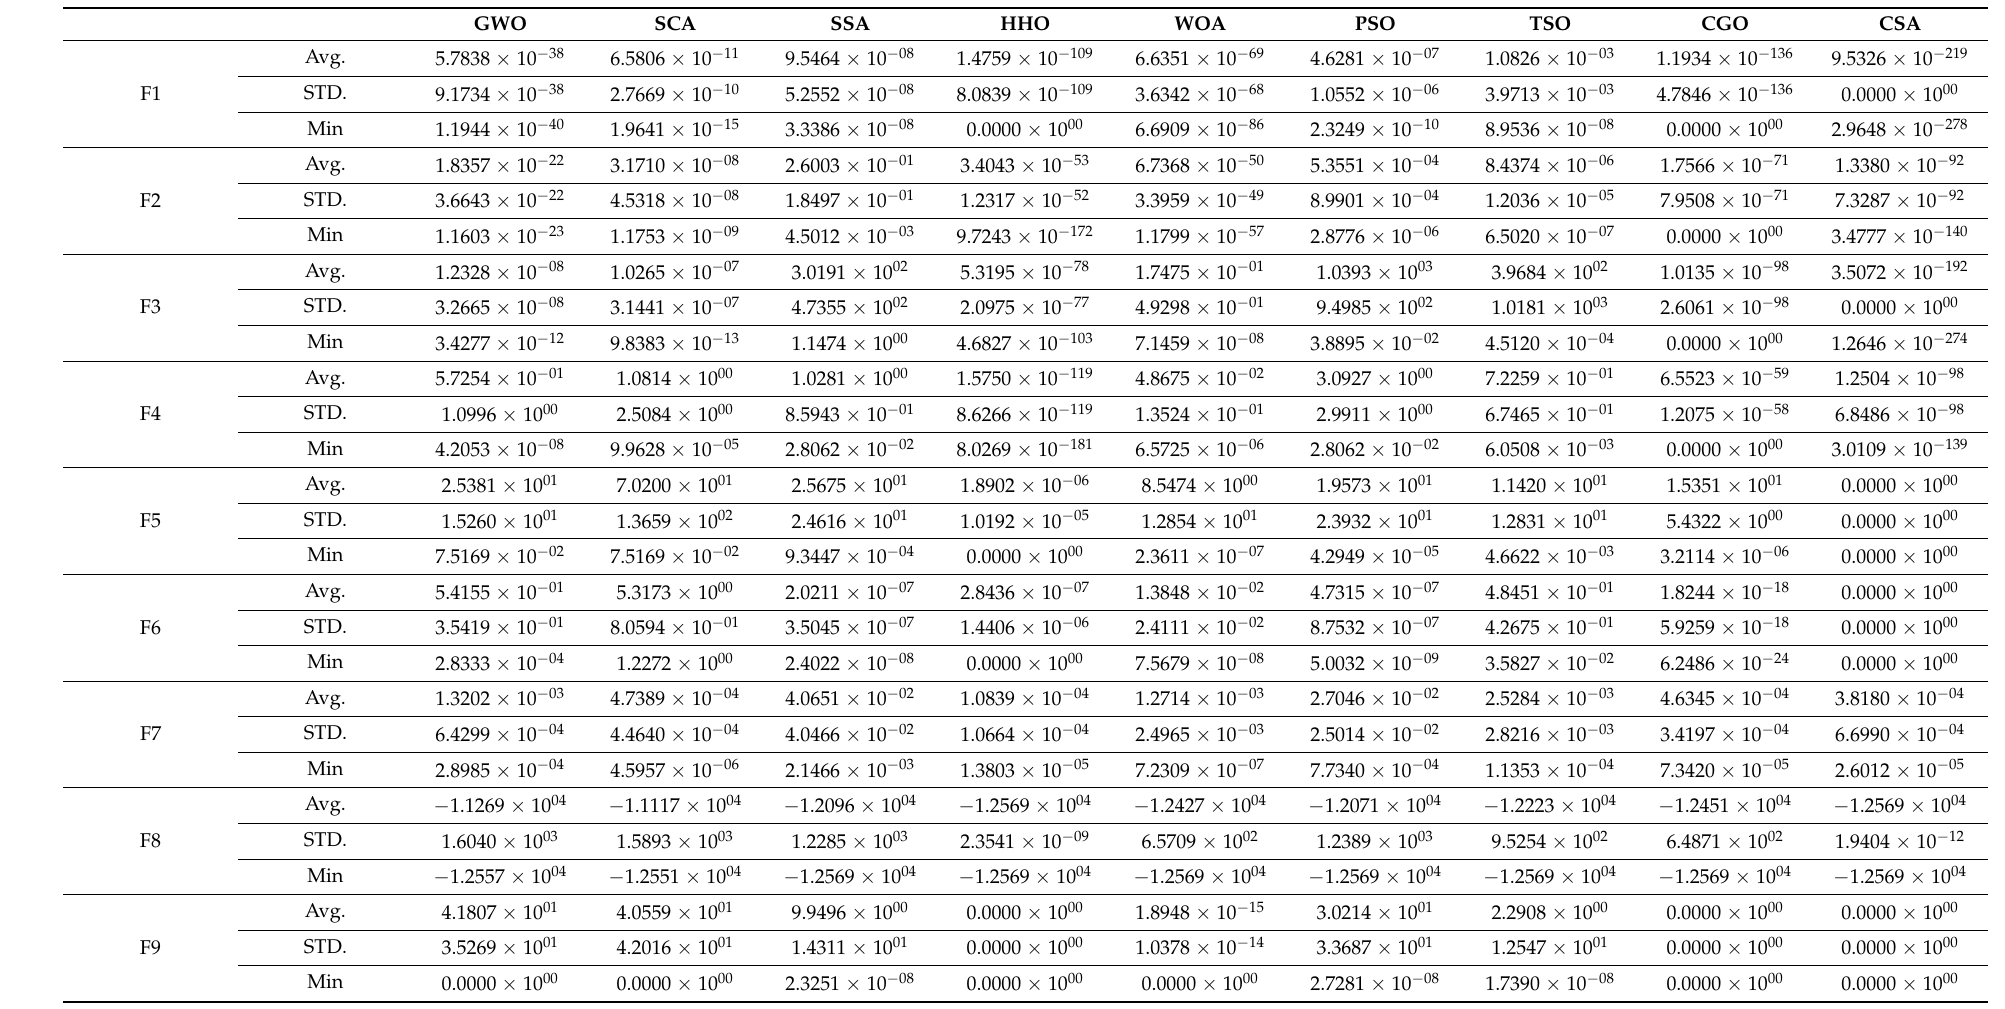
Table 6. Statistical results of the optimized standard functions with d =